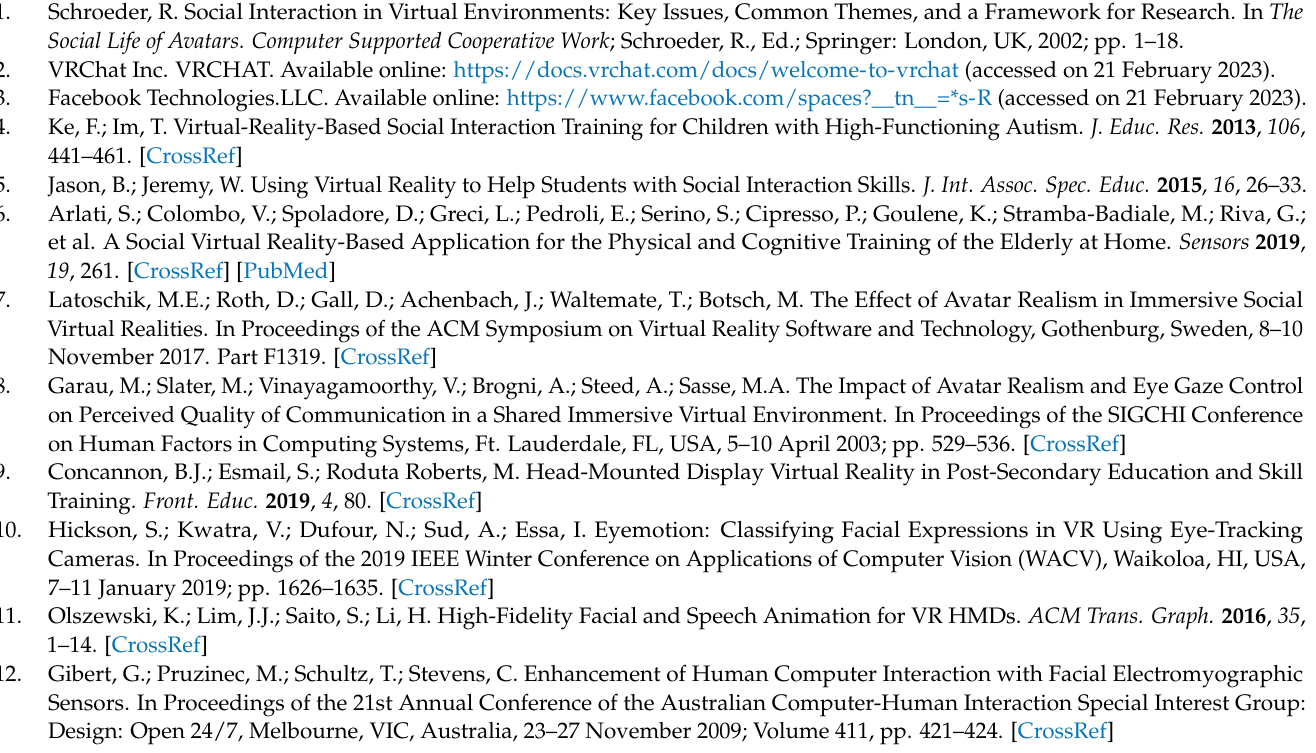
f-clone system; Table S2: List of all facial gestures reconstructed in this study and blend shape